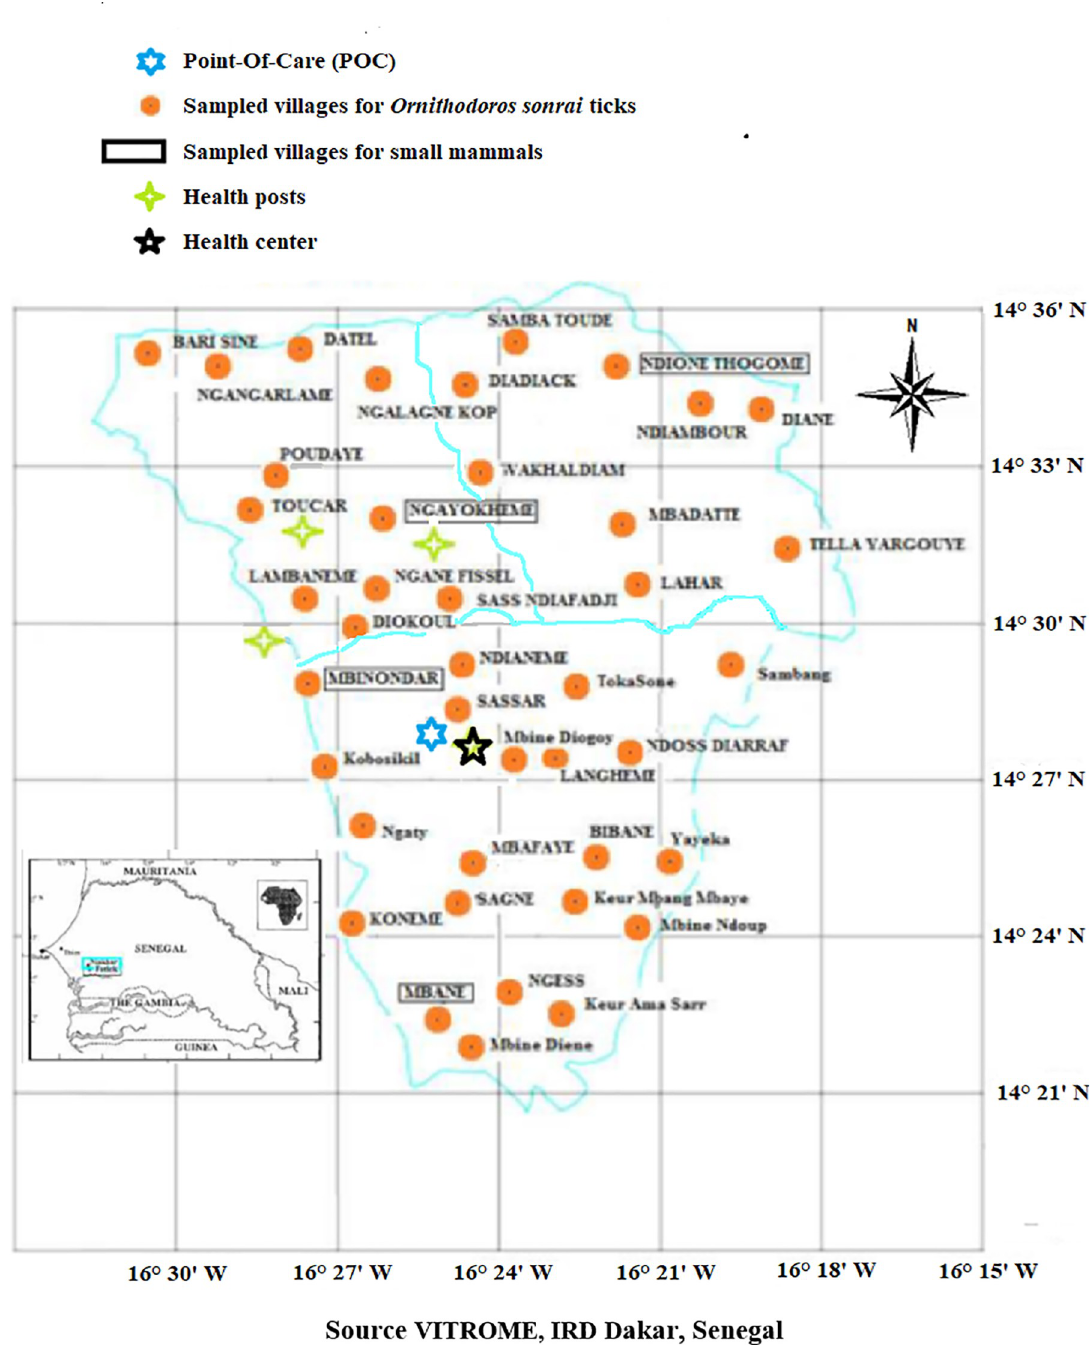
Fig 3. Sampling design for O. sonrai ticks (orange circles) and capture of small rodents and insectivores (villages in the boxes), with the presence of health posts (green star) and the health center in the Niakhar district (source VITROME, IRD Dakar, Senegal).